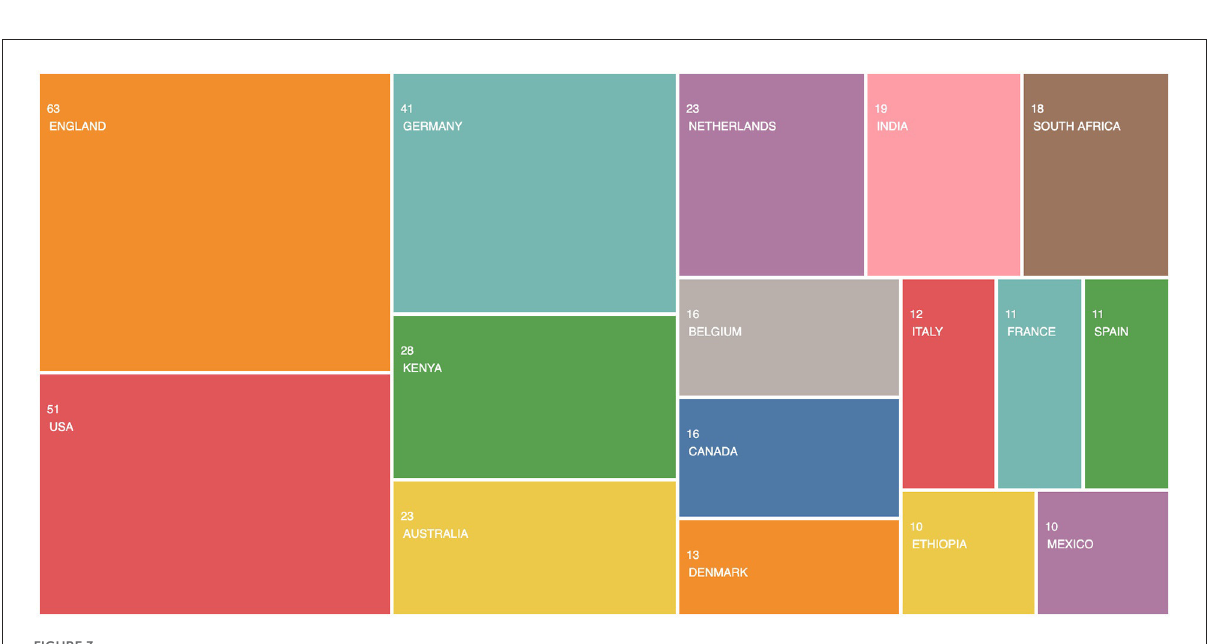
chains: (1) labor governance in global agri-food value chains through standards, (2) employment in agri-food value chains and impacts on socioeconomic conditions of rural areas, (3) gender issues and agri-food value